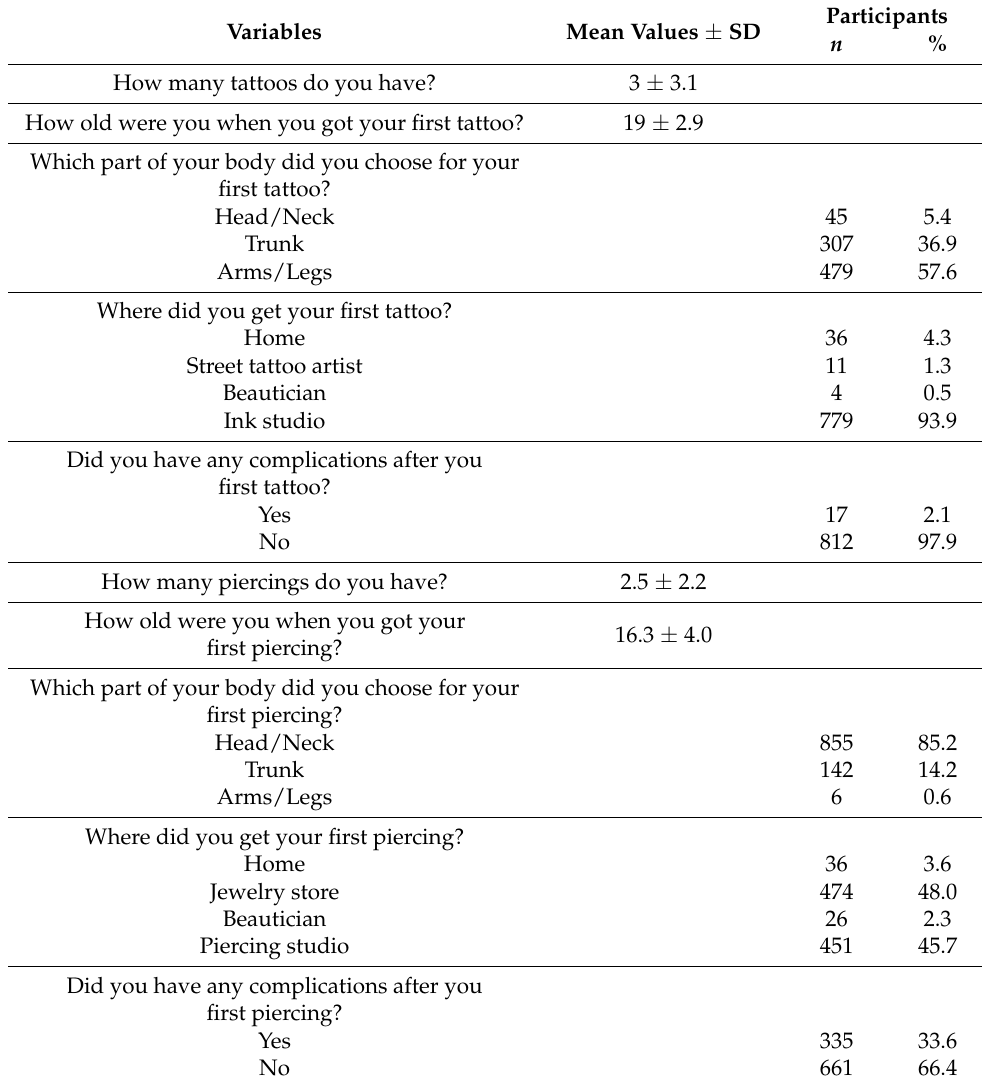
Table 2. Information related to tattooing and body piercing experience of participants (tattooed n = 833; pierced n =